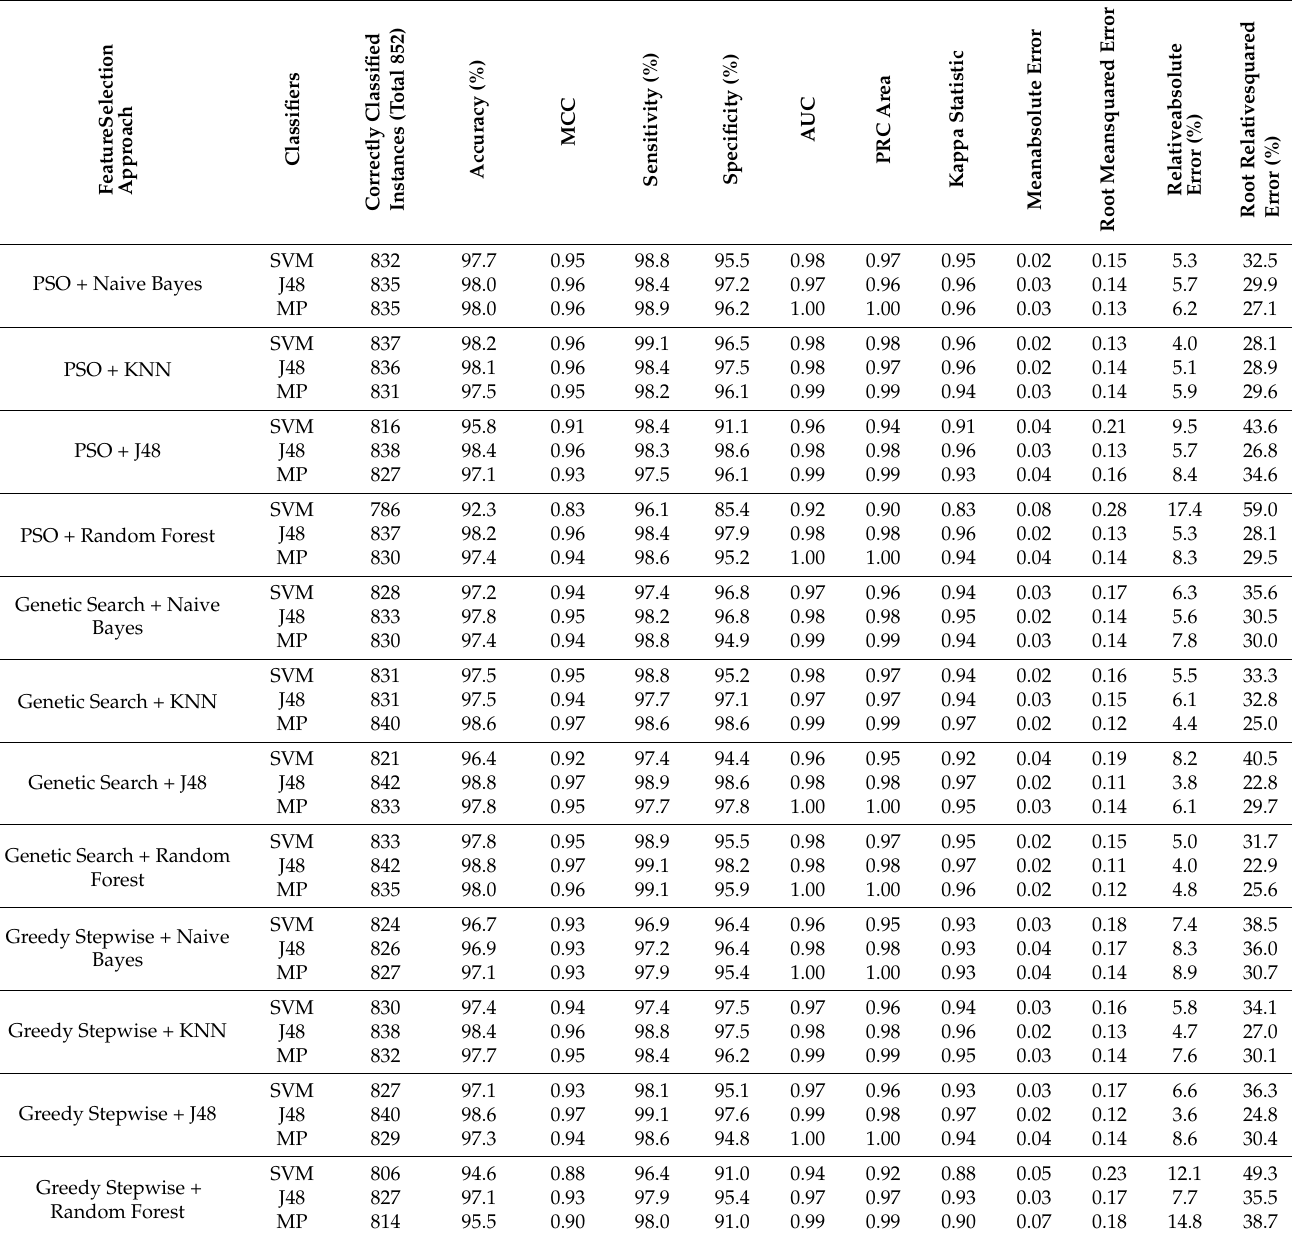
Table 6. Comparative accuracy evaluation of classifiers with various feature selection approach. On data after preprocessing with resampling +